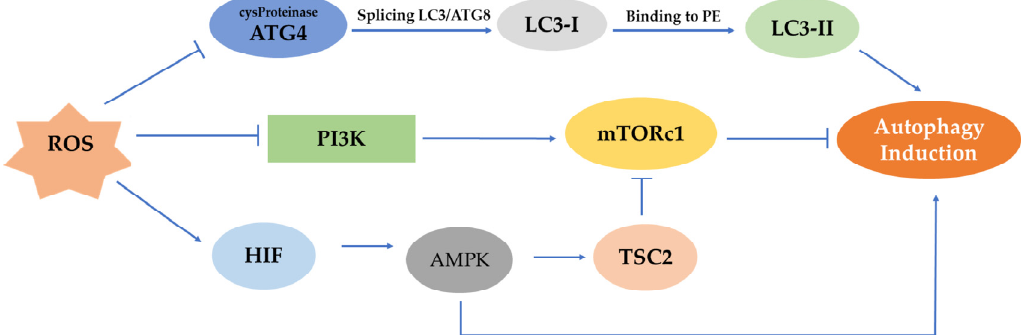
Figure 3. Representation of mTOR, AMPK, PI3K/Akt pathways and their effect on the induction of autophagy. ROS can prevent the activation of ATG4 protease, which splices LC3/Atg8 to produce LC3-I, and this, in turn, after its binding to PE, induces autophagy. In a different mechanism, the AMPK pathway is being activated under hypoxia by HIF, and autophagy can be initiated. However, in the PI3K/Akt pathway, the control of mTORc1 through ROS-mediated inhibition of PI3K can suppress autophagy.